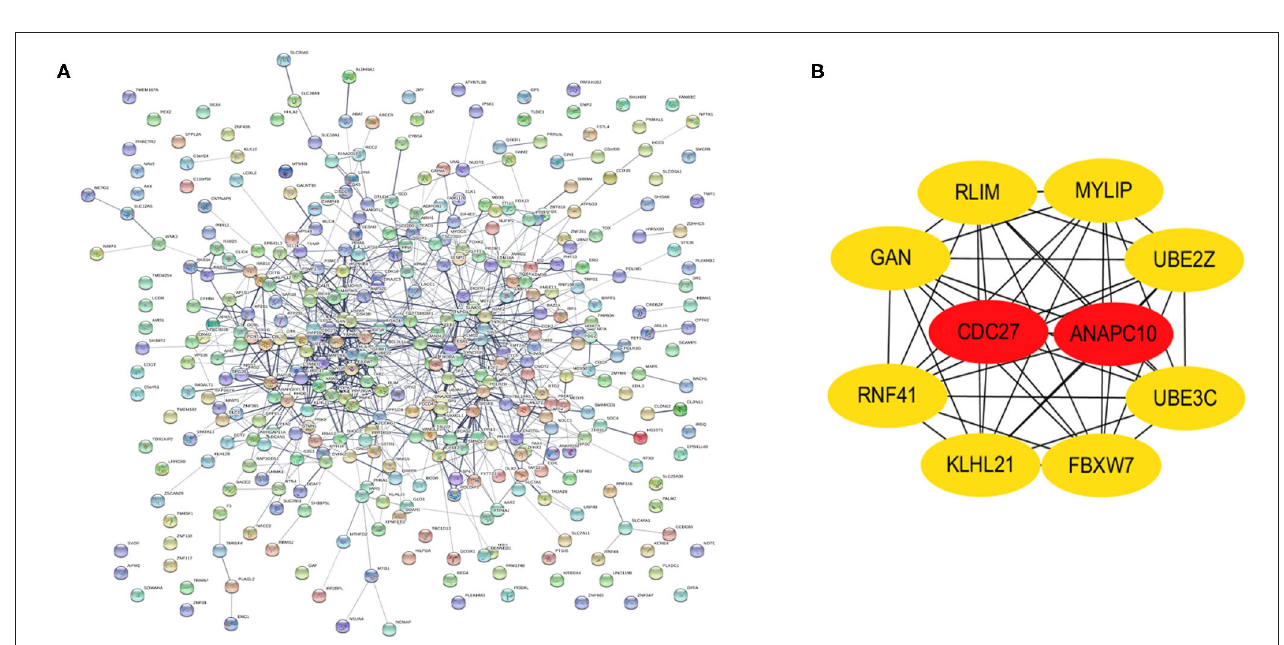
FIGURE 7 | Identification of hub genes from the PPI network with the MCODE and Cytohubba algorithm. (A) PPI network of 370 genes. (B) PPI network of ten hub genes that extracted from the PPI network.